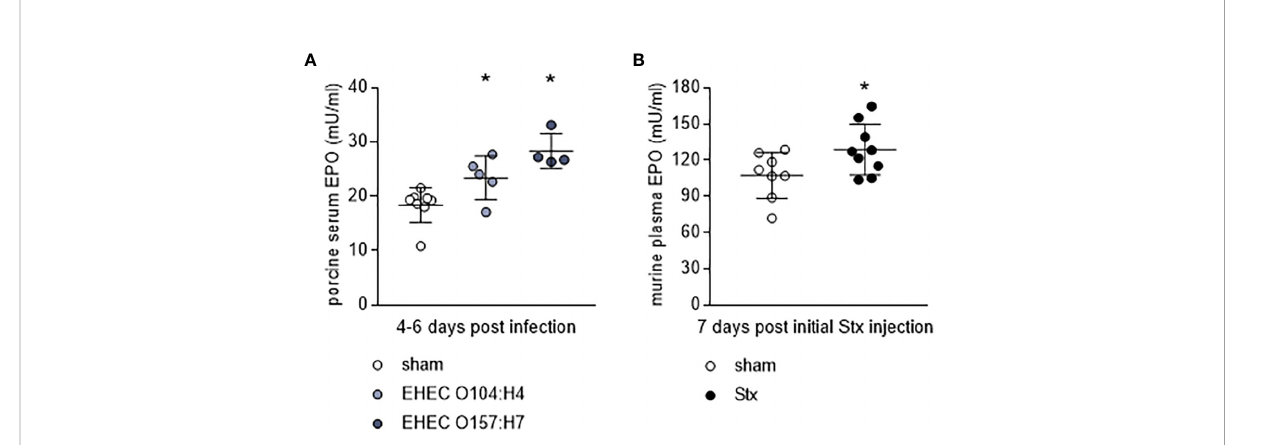
FIGURE 2 Endogenous EPO levels in animal models of HUS. (A) EPO serum levels in gnotobiotic piglets that were either mock-infected (sham) or infected with EHEC O157:H7 or EHEC O104:H4 determined by ELISA. Samples were taken 4-6 d after infection (sham n = 8, EHEC O104:H4 n = 5, EHEC O157:H7 n = 4). Data are expressed as scatter dot plot with mean ± SD. *P < 0.05 vs. sham (one-way ANOVA, Holm-Sidak ’ s multiple comparison test). (B) EPO plasma levels in mice with HUS on day 7 of experiment (sham n = 8, Stx n = 10) determined by ELISA. Data are